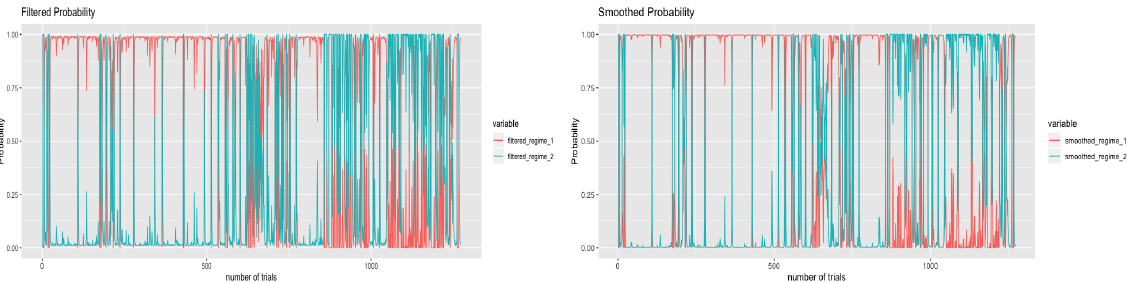
Figure 7. The filtered and smoothed probabilities of fuel-switching data.